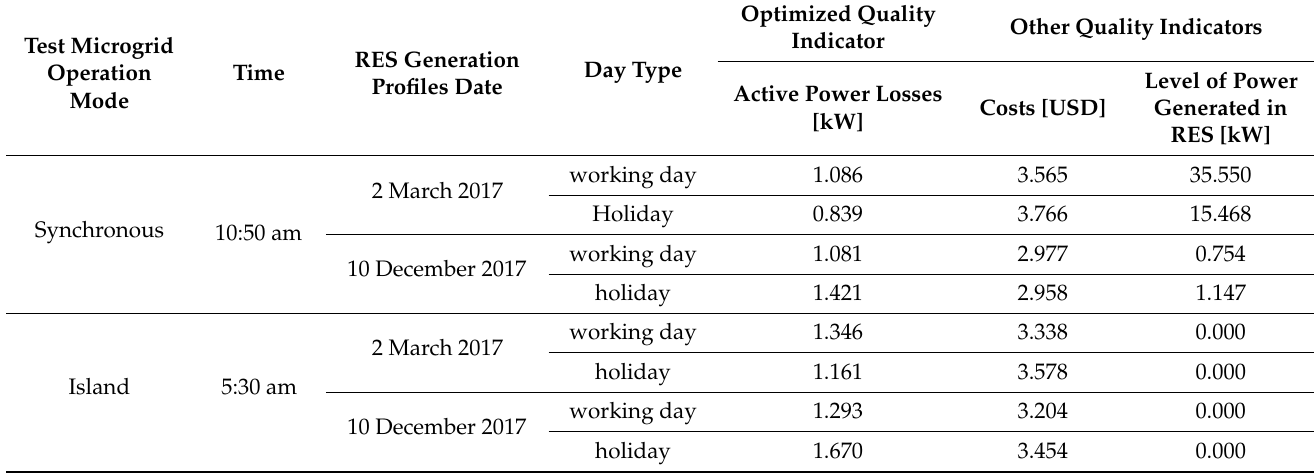
Table 4. Selected results of optimization calculations in task